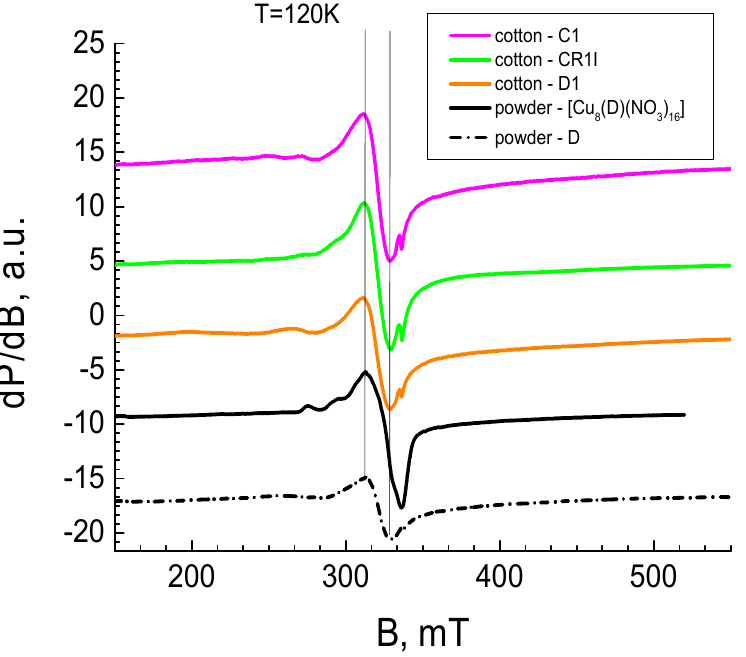
Figure 4. EPR spectra of cotton fabrics at 120 K: D1 (orange line), C1 (magenta line), CR1I (green line). EPR spectra of the powdered dendrimers: dendrimer (black dash-dot line), dendrimer complex (black solid line).